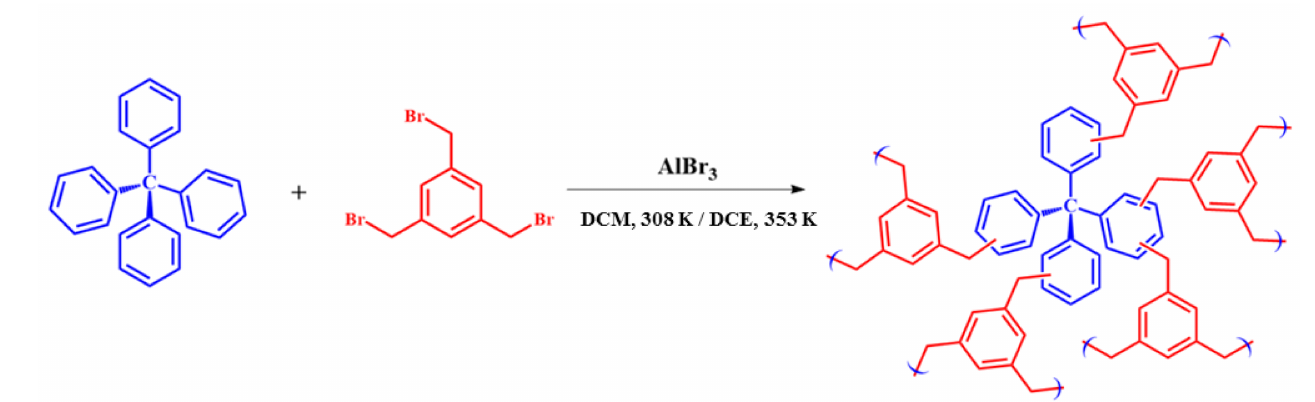
Figure 1. Reaction scheme for the synthesis of ABT hyper crosslinked